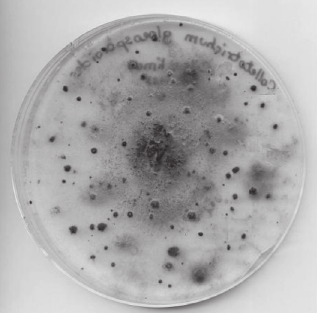
Figure 2. Macroscopic aspect of Colletotrichum gloeo- sporioides on PDA